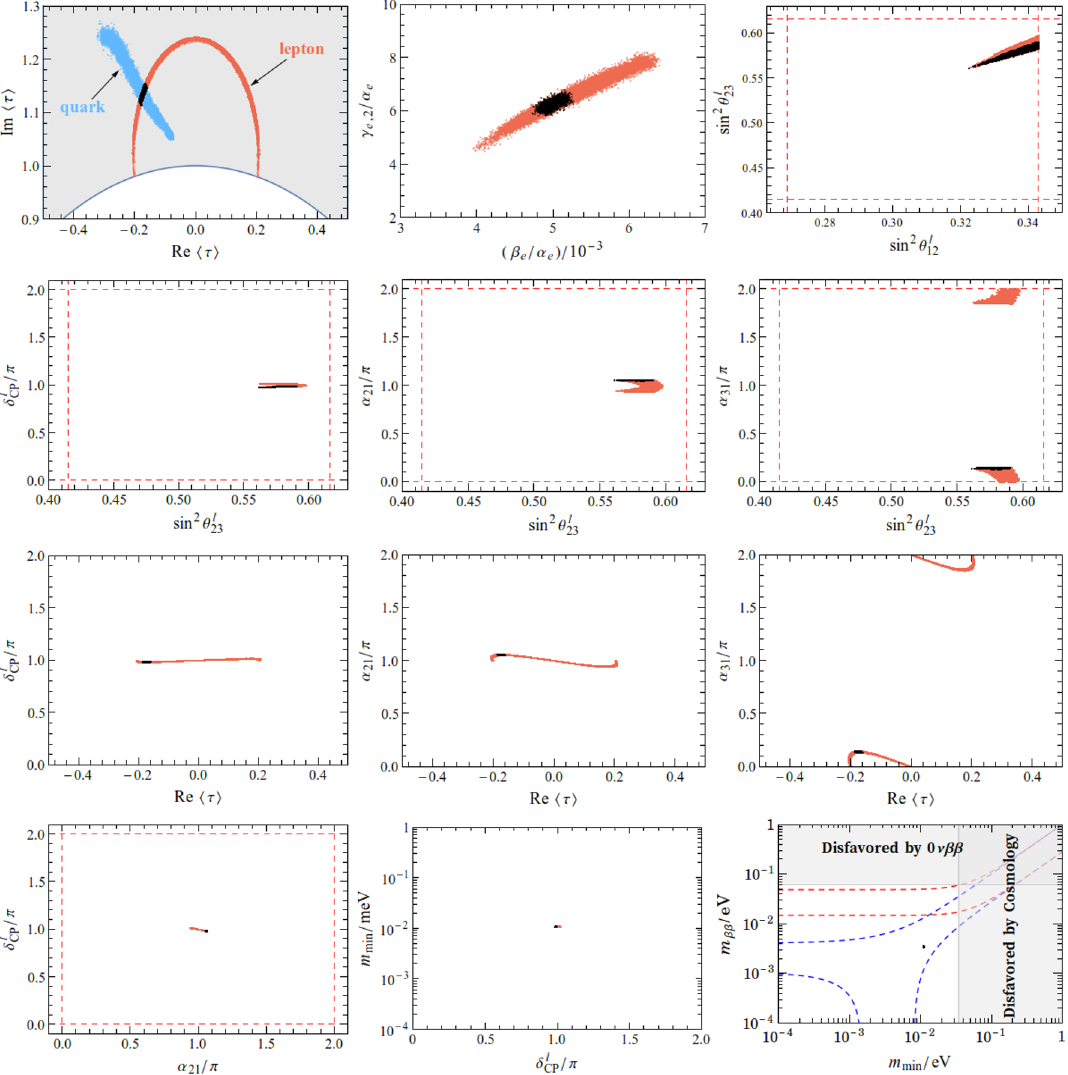
Figure 2 . The predictions for the correlations among the input free parameters, neutrino mixing angles, CP violation phases and neutrino masses in the unified model L areas denote points compatible with experimental data of quarks and leptons respectively, and the black is the overlapping region. The vertical and horizontal dashed lines are the 3 σ bounds taken from